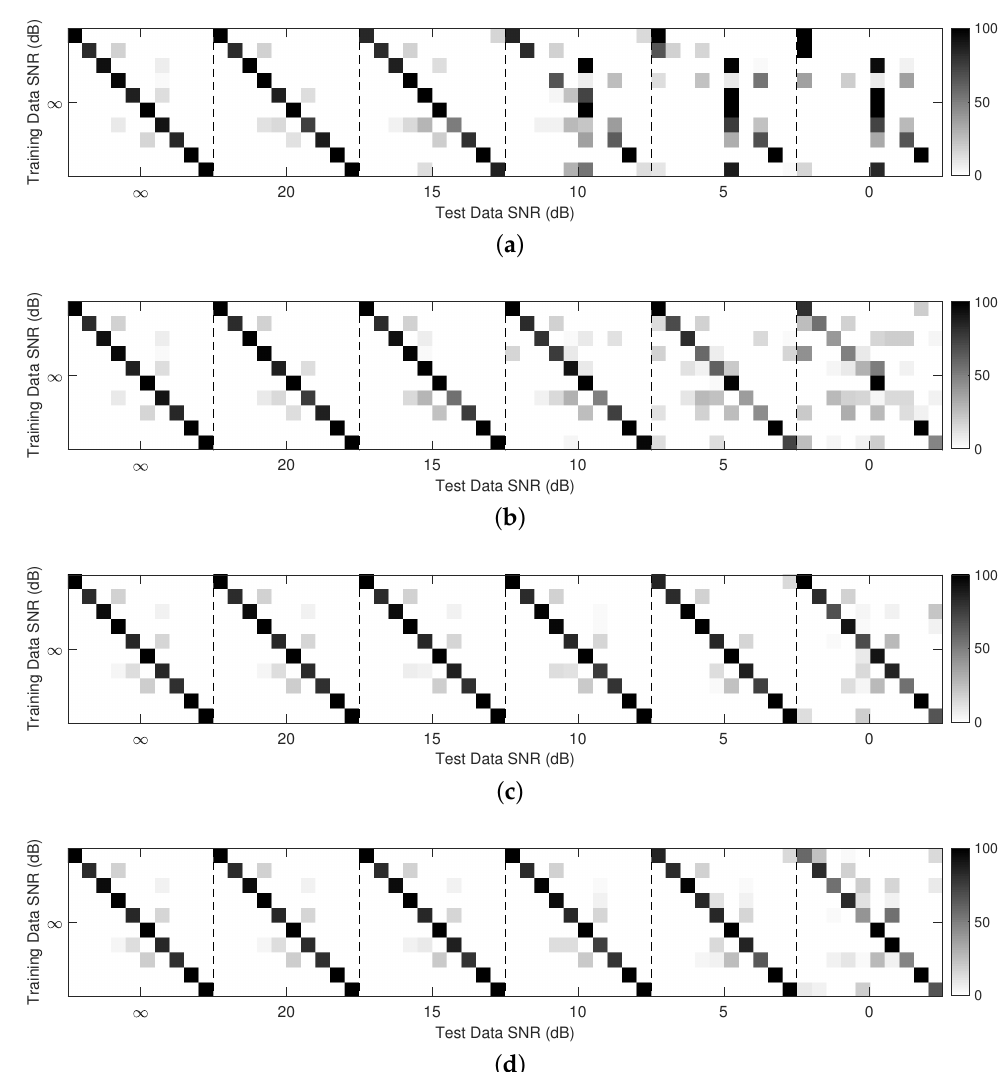
Figure 6. Confusion matrix of subject 1. ( a ) None. ( b ) Denoising. [17] ( c ) Proposed method using ideal noise power. ( d ) Proposed method using estimated noise